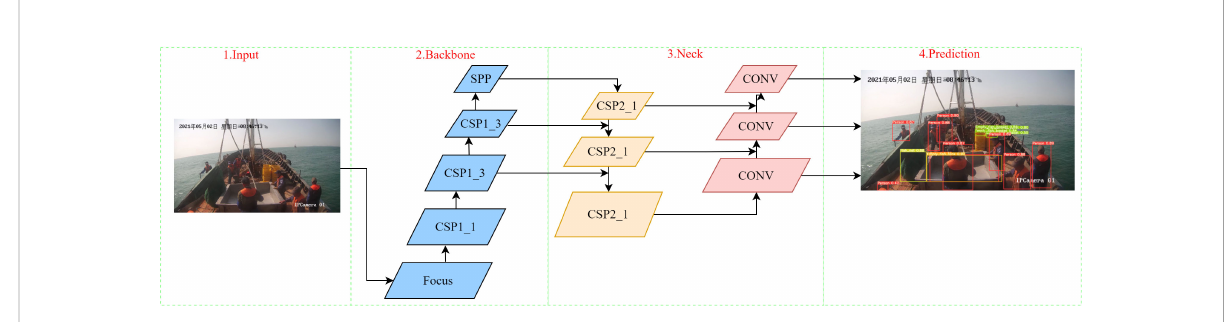
FIGURE 4 YOLOv5s algorithm network